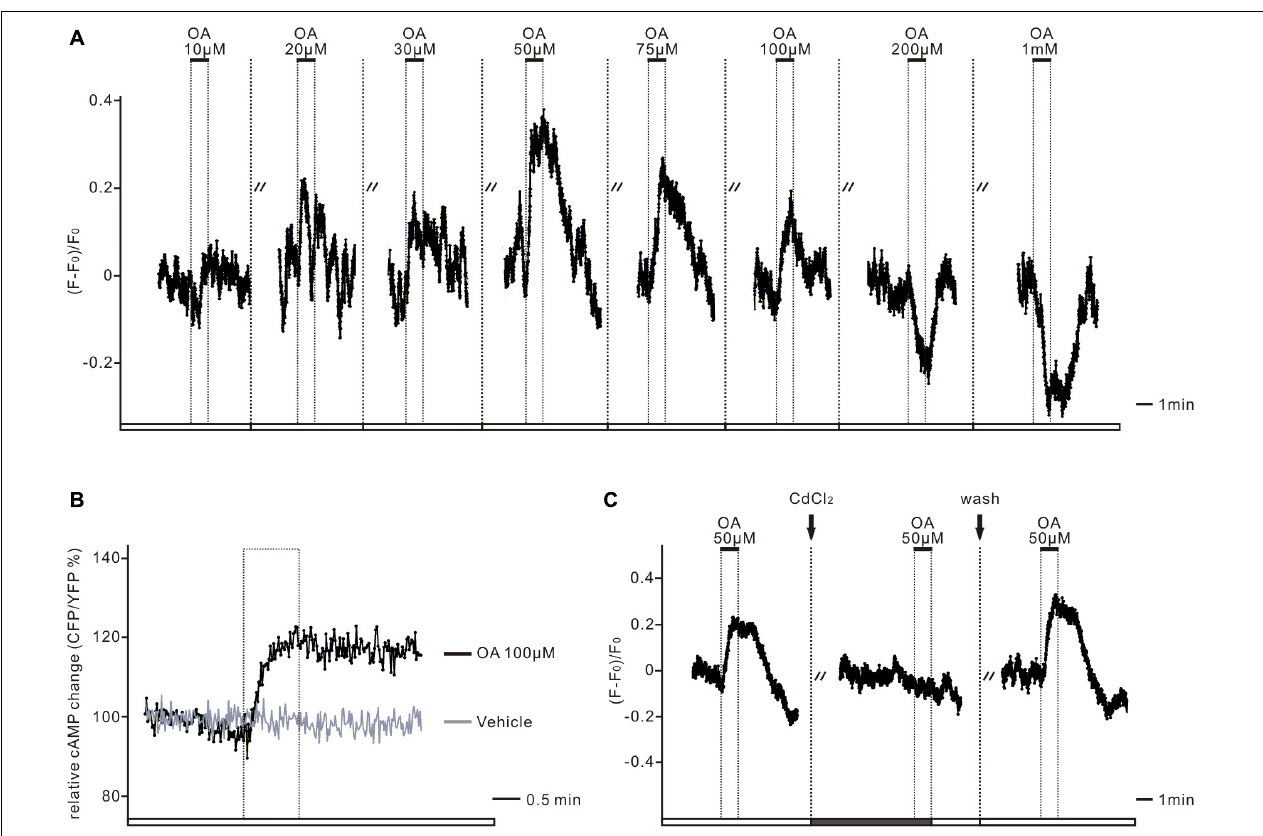
FIGURE 5 | The dual-directional action of octopamine was mediated via OCT β -type receptors. (A) The representative deltaF/F trace shows the Ca 2 + response in one GCaMP6m-expressing PTTH neuron. Low doses of octopamine (OA) treatment (10–100 µ M) initially led to increases, whereas higher doses (200 µ M–1 mM) resulted in decreases of intracellular Ca 2 + levels in all of the imaged PTTH cells ( n = 7). Dashed lines display 5 min applications of washes. Solid bars indicate the duration (1 min) of the respective neurotransmitter application. (B) The Epac-camp inverse FRET trace for PTTH cells to bath application of 100 µ M OA results in elevated cAMP levels in contrast to the vehicle control. The dashed box indicates the duration of the respective drug treatment. (C) 300 µ M treatment of the voltage-dependent Ca 2 + channel antagonist cadmiumchlorid (CdCl 2 ) abolished OA (50 µ M) induced Ca 2 + increases in GCaMP6m-expressing PTTH cells ( n = 6). Dashed lines display 1 min application of CdCl 2 and 5 min application of washes. Solid bars indicate the duration of the respective drug application (1